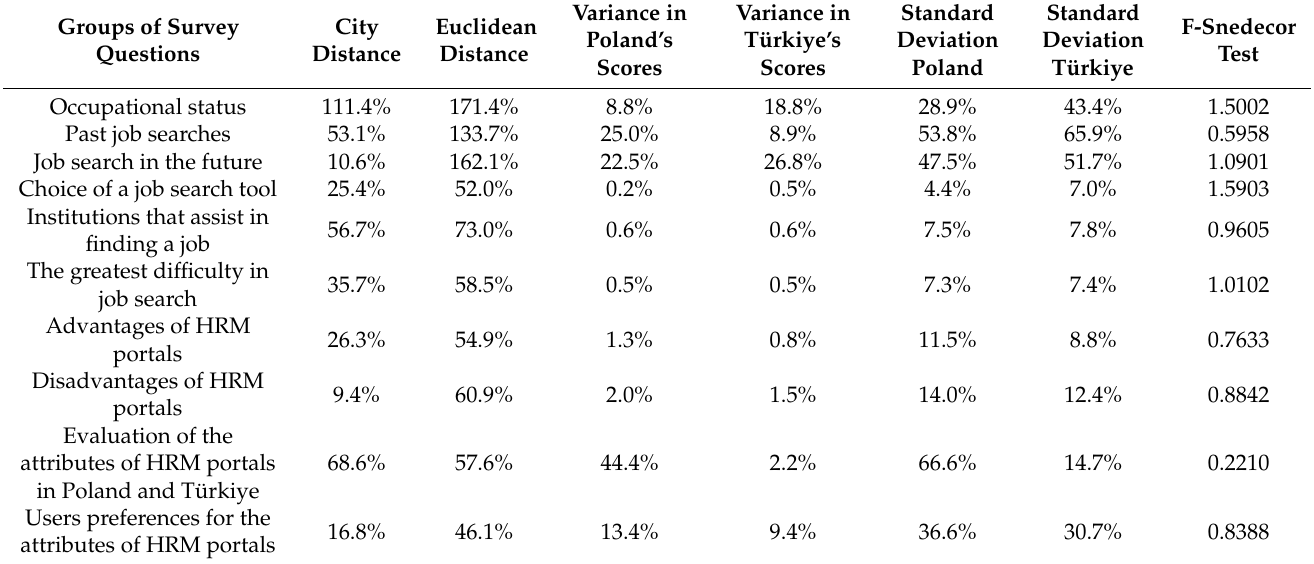
Table 6. Differences in groups of survey questions between Poland and